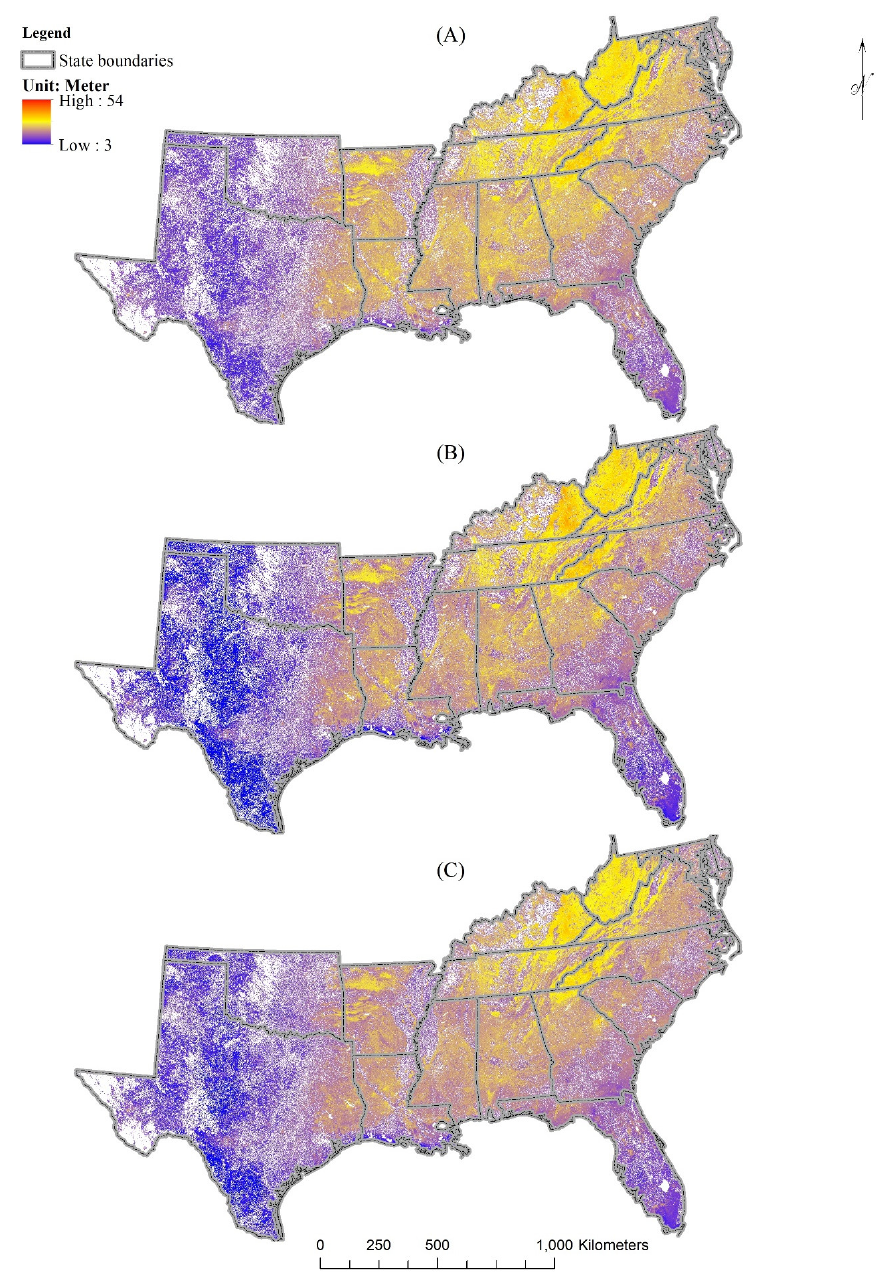
Figure 8. The recalibrated GCHMs: ( A ) simGCHM, Simard et al. (2011), restricted to the southern United States; and the recalibrated GCHM using all points of 90th percentile heights at 0 m height category with ( B ) 80% data and ( C ) 20% data.